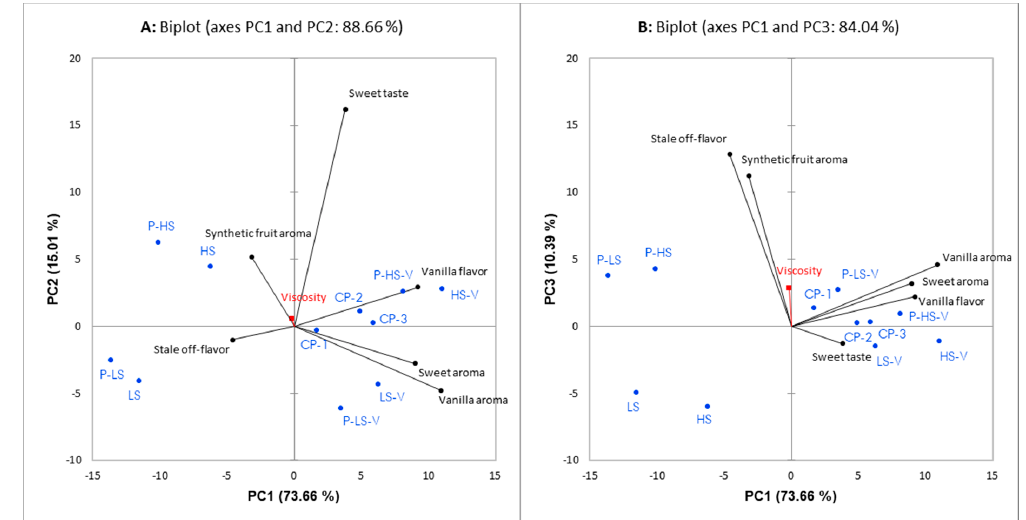
Figure 1. Principal Component Analysis (PCA) biplots of the results from the Descriptive Analysis (DA) of the aqueous matrix. PC1 versus PC2 ( A ) and PC1 versus PC3 ( B ) is shown. PC1 explains 73.66%, PC2 15.01%, and PC3 10.39% of the variation in the data. Attributes are marked in black, samples in blue, and the supplementary variable viscosity in red. Samples are labelled according to Table 1.